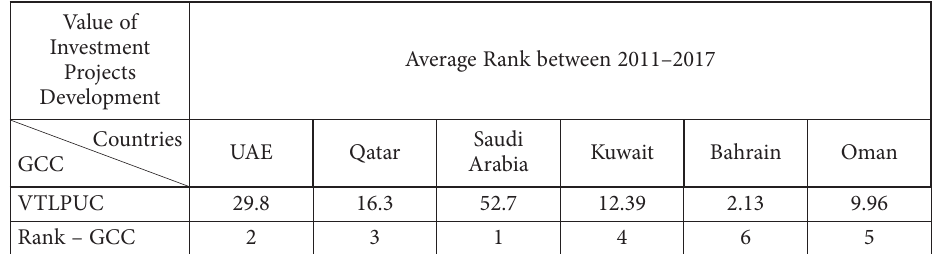
Table 2. Value of ten largest projects underway in the GCC countries and rank (VTLPUC) (US$ Bil- lion) (source: Middle East Economic Digest (MEED) Projects (2018b) From 2011–2017. Source of Rank: